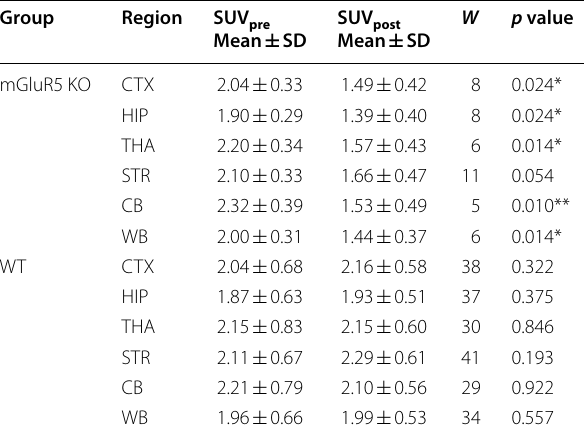
Table 3 Wilcoxon rank test results for pairwise comparisons in mGluR5 KO and WT mice